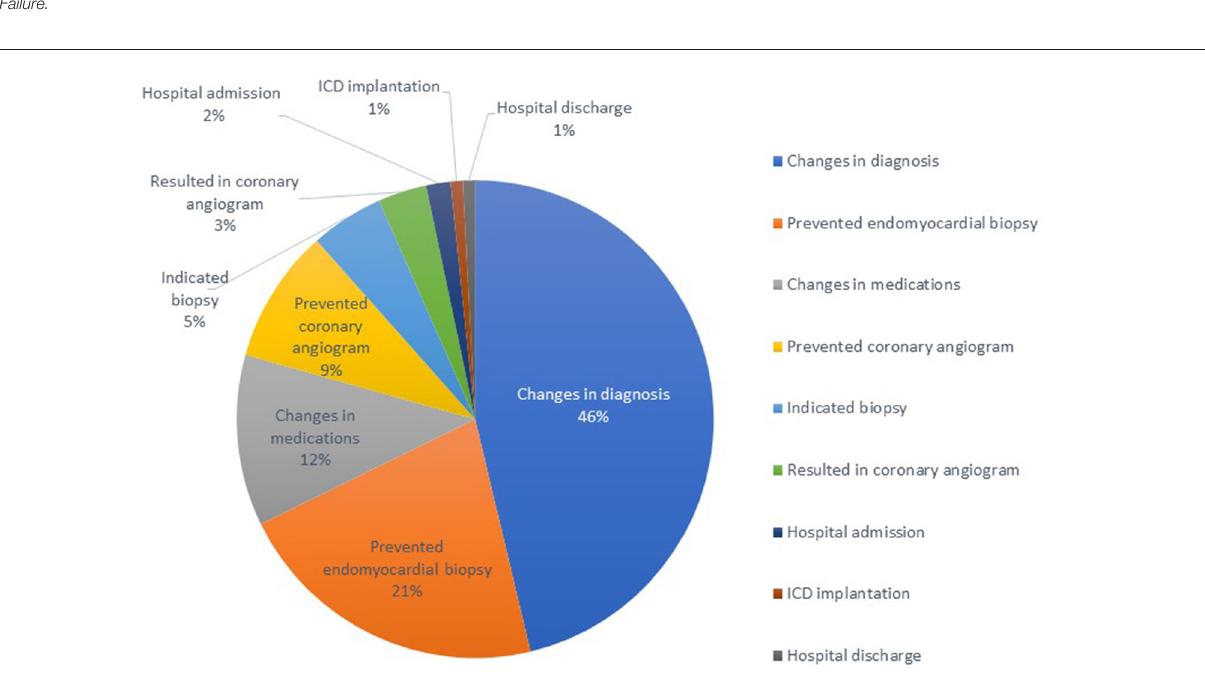
CMR is a cornerstone test in the evaluation of patients with left ventricular hypertrophy (LVH) phenotype on